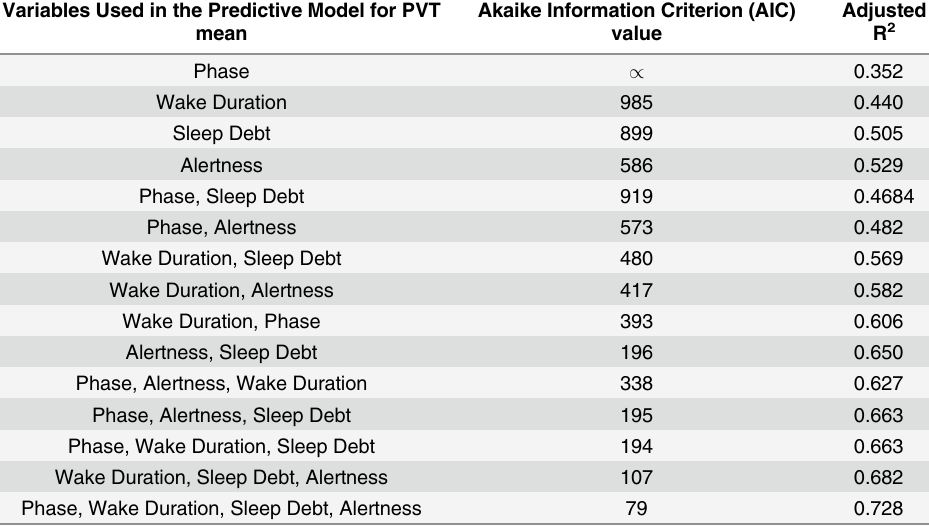
Table 2. Table of Akaike Information Criterion (AIC) and Adjusted R 2 values for the different predictive models of PVT mean. Variables Used in the Predictive Model for PVT